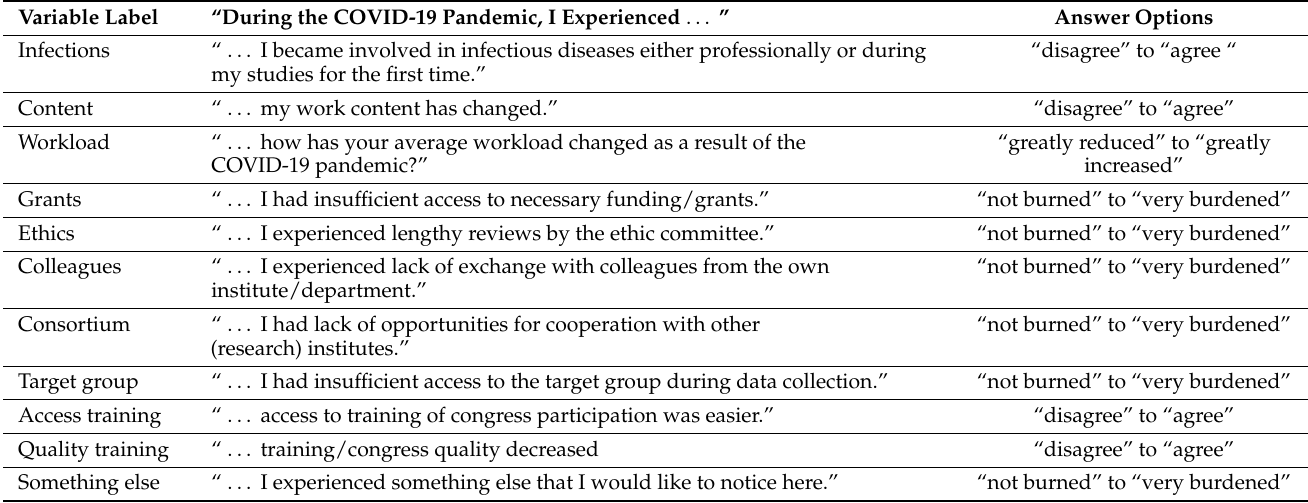
Table 2. Items for assessing working